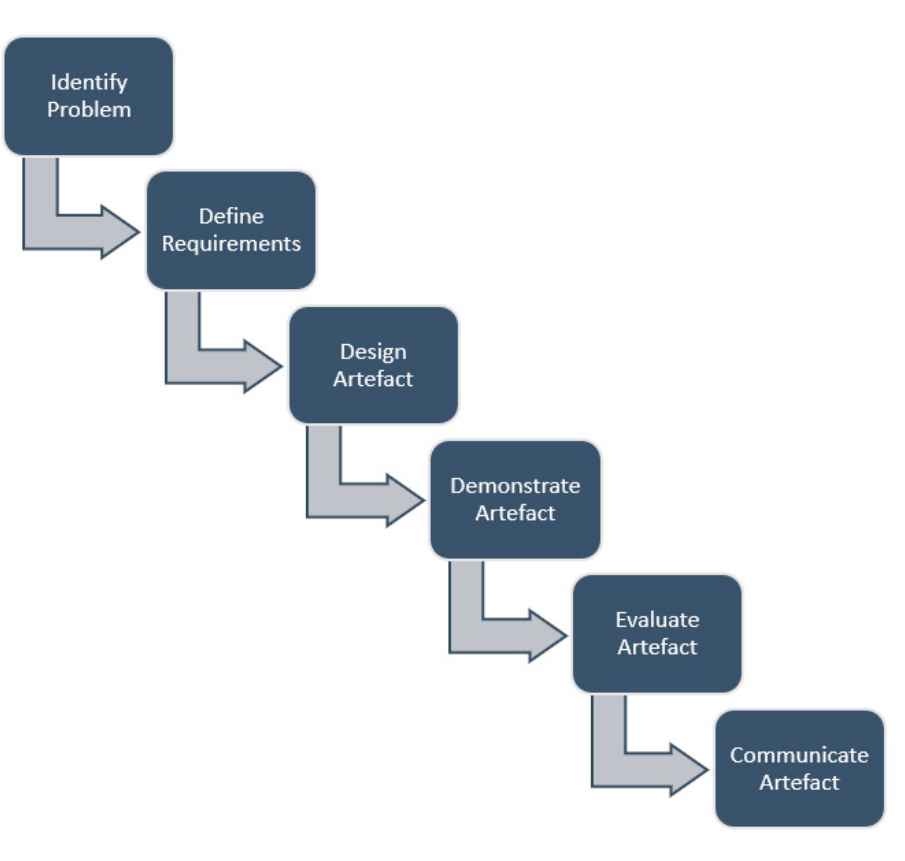
Figure 2. Research Figure 2. Research approach.